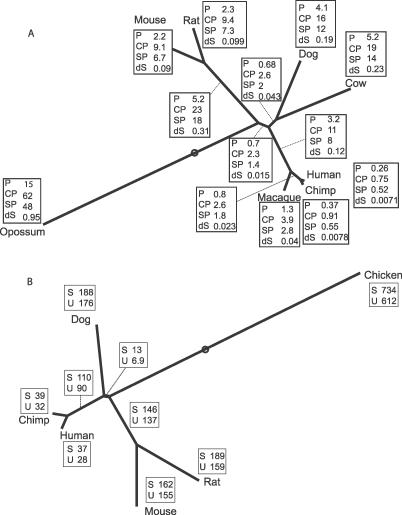
Distance Phylogenetic Trees of Mammals(A) The phylogenetic tree of the mammals is shown here with branch lengths obtained using different distance criteria shown in the tables: PAM distance (P), CodonPAM (CP), SynPAM (SP), and dS (dS). The branch lengths shown are proportional to PAM distance, and the circle indicates the placement of the root.(B) The phylogenetic tree of the mammals constructed using signed (S) and unsigned (U) reversal distance, with branch lengths proportional to the number of signed reversals.